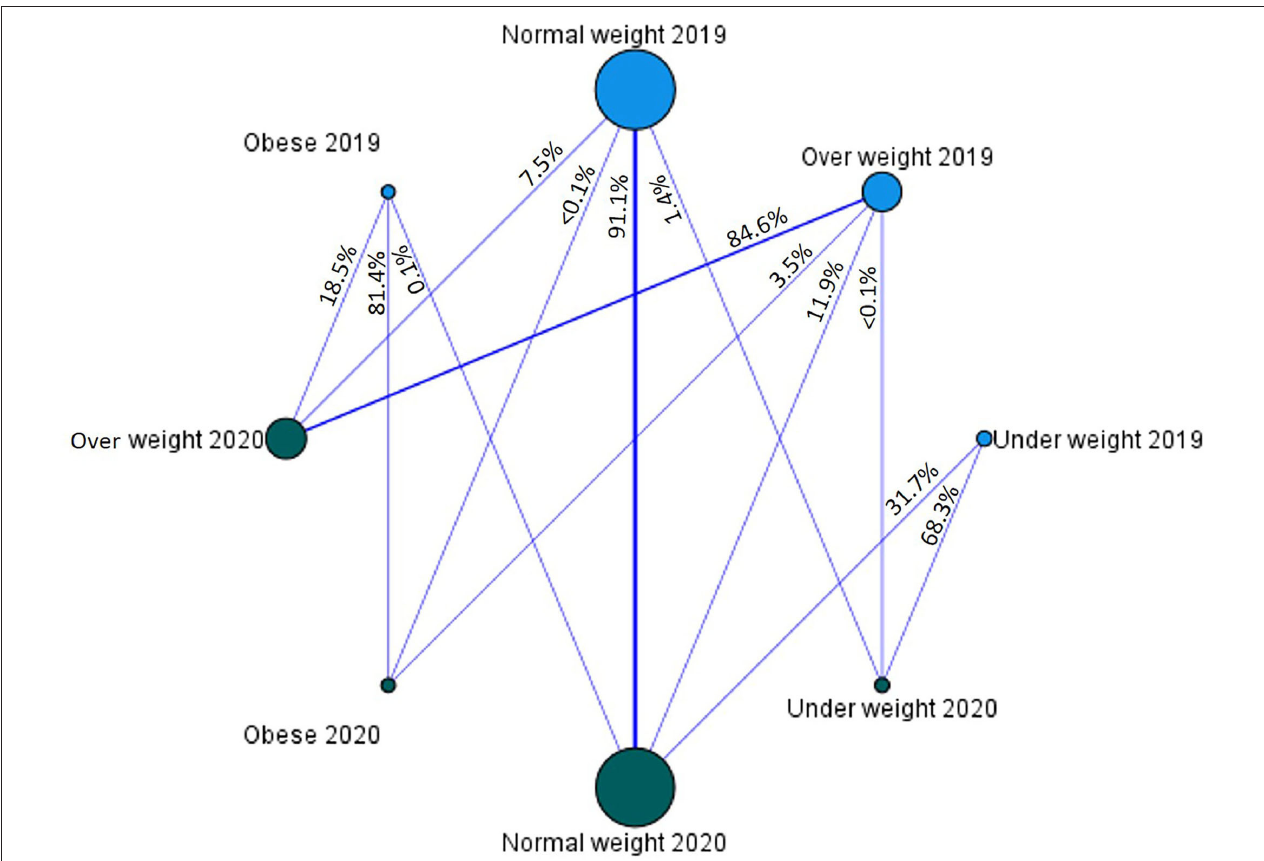
FIGURE 1 | The flow graph of BMI categories between 2019 to 2020 ( P value < 0.001).